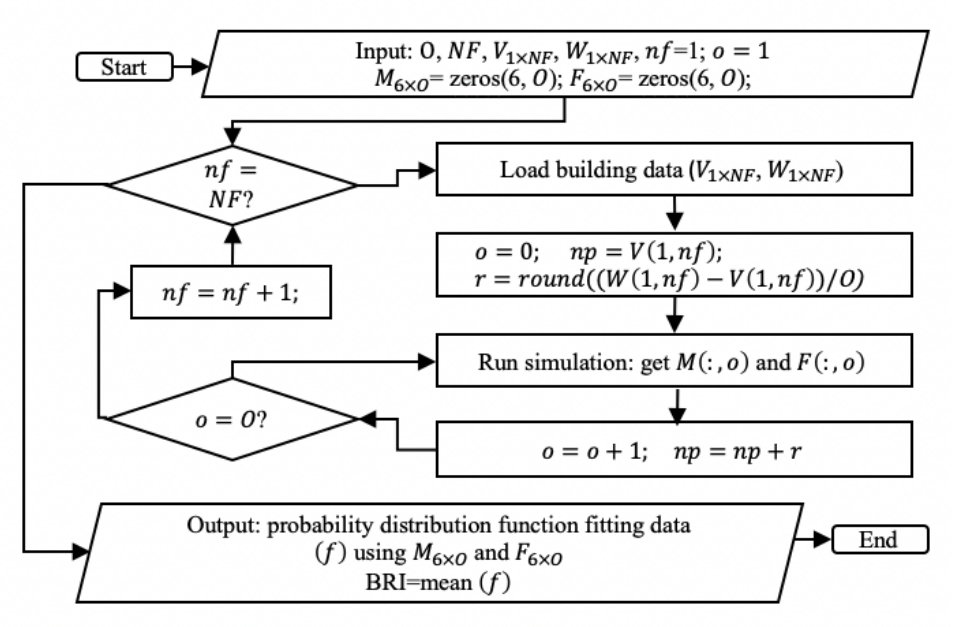
Figure 6. Flowchart of the